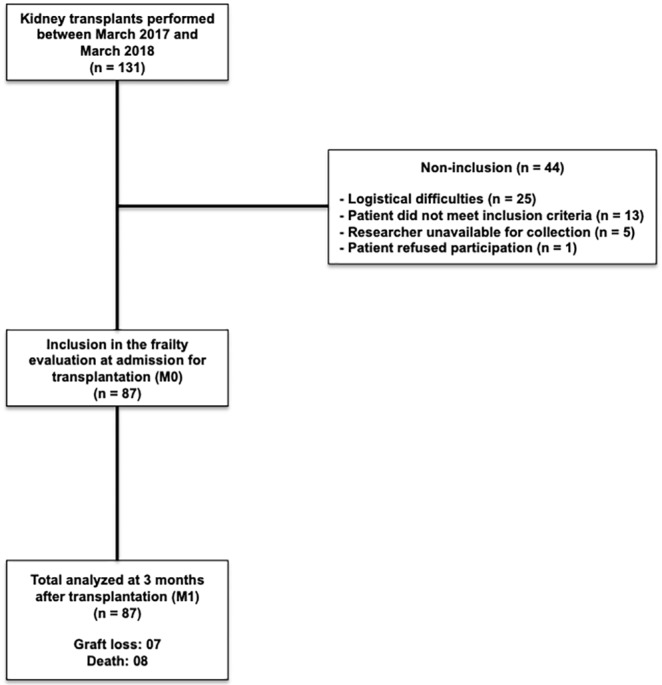
Patient disposition.